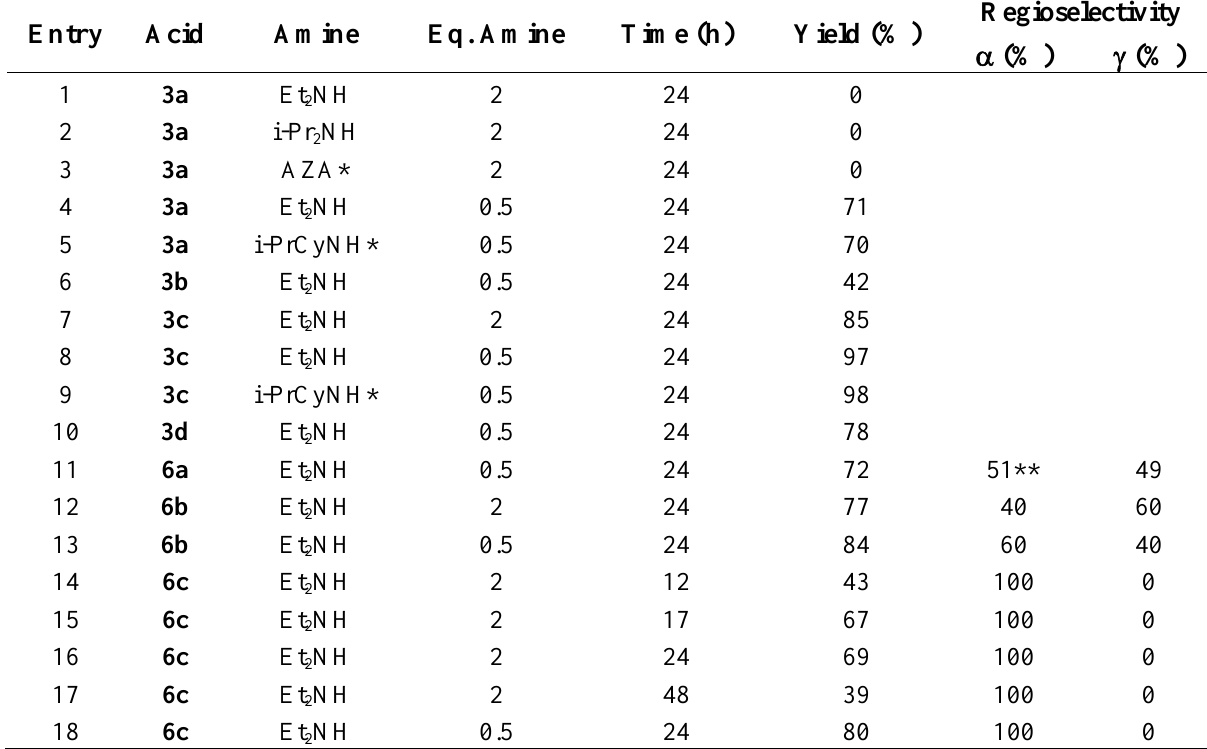
Table 1 . Addition of dianions of carboxylic acids to